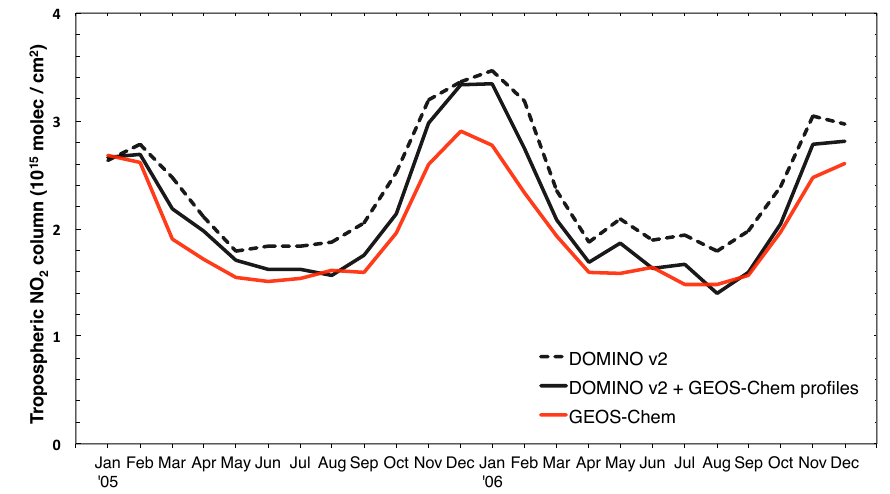
Fig. 4. Comparison of monthly averaged OMI and GEOS-Chem tropospheric NO 2 columns for 2005–2006 averaged over (central) Europe defined in Fig. 3. Selection of OMI observations follows the same criteria as Fig. 3.